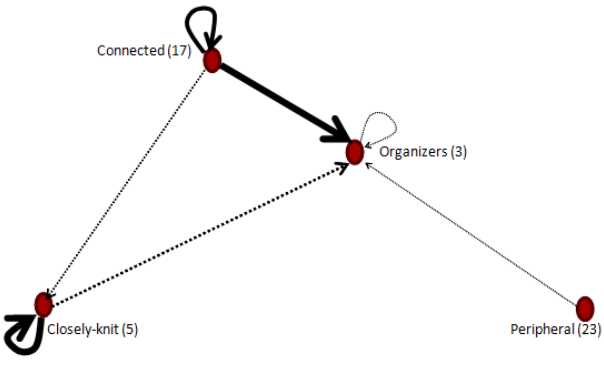
Fig. 1 . Advice exchange network between four subgroups defined according to their relational proximity.